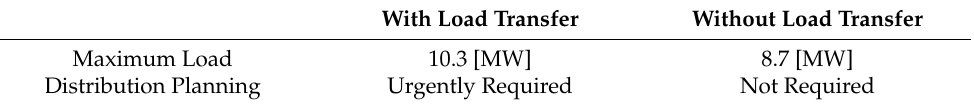
Table 1. Example of the error in distribution planning due to load